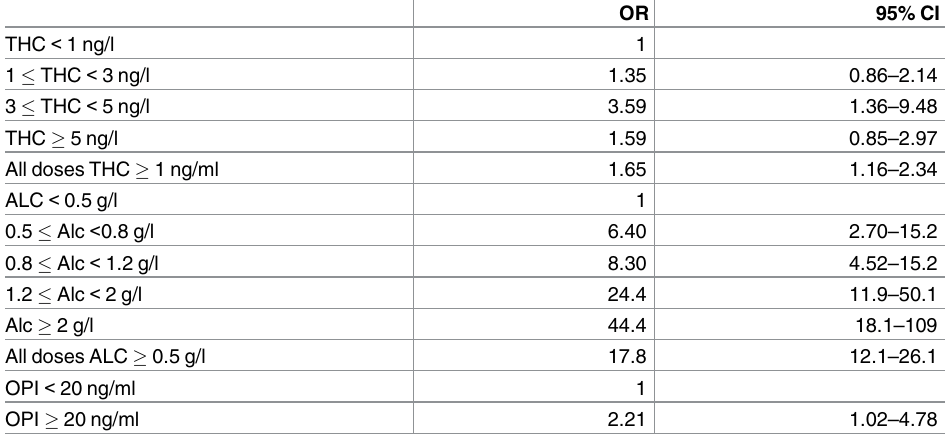
Table 4. Adjusted ORs * for driver responsibility linked to driving under the influence (n = 4,047 ** , data source Voiesur 2011, fatal accidents).